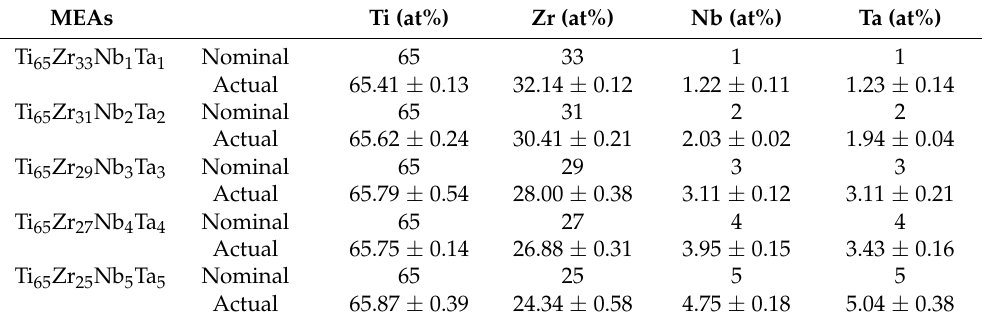
Table 1. Energy-dispersive X-ray spectroscopy results for the Ti–Zr–Nb–Ta medium-entropy alloys (MEAs). MEAs Ti (at%) Zr (at%) Nb (at%) Ta (at%) Ti 65 Zr 33 Nb 1 Ta 1 Nominal 65